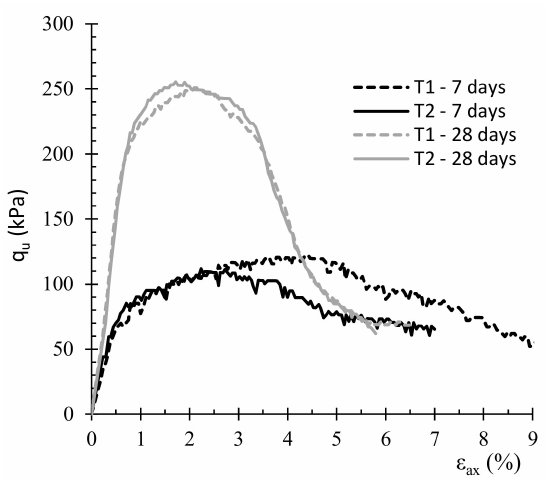
Figure 2. Stress–strain curves for the reference test conditions (soil chemically stabilized with Portland